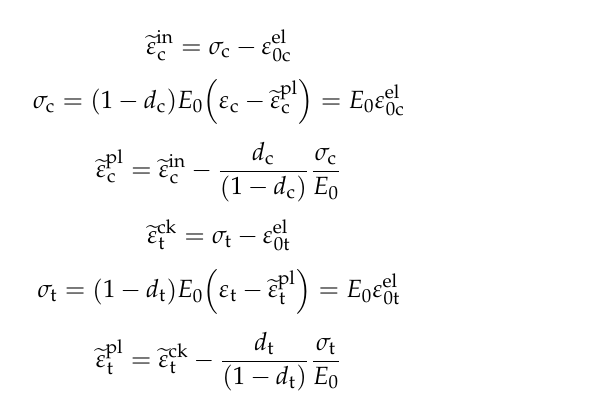
The concrete damage plasticity (CDP) model in Abaqus [23] uses different damage factors for tension and compression to describe the stiffness degradation, as shown in Figure 2. The uniaxial compressive stress–strain curve in the CDP model is given by Equations (10)–(12), where d c is the concrete uniaxial compression damage factor, (cid:101) ε in is the c concrete compressive inelastic strain, ε el is the concrete compressive elastic strain at initial 0c stiffness, and (cid:101) ε pl c is the concrete compressive equivalent plastic strain. The uniaxial tensile stress–strain curve equation in the CDP model is given by Equations (13)–(15), where d t is the concrete uniaxial tension damage factor, (cid:101) ε ck is the concrete tensile fracture strain, ε el is t 0t the concrete tensile elastic strain at initial stiffness, and (cid:101) ε pl is the concrete tensile equivalent c t plastic